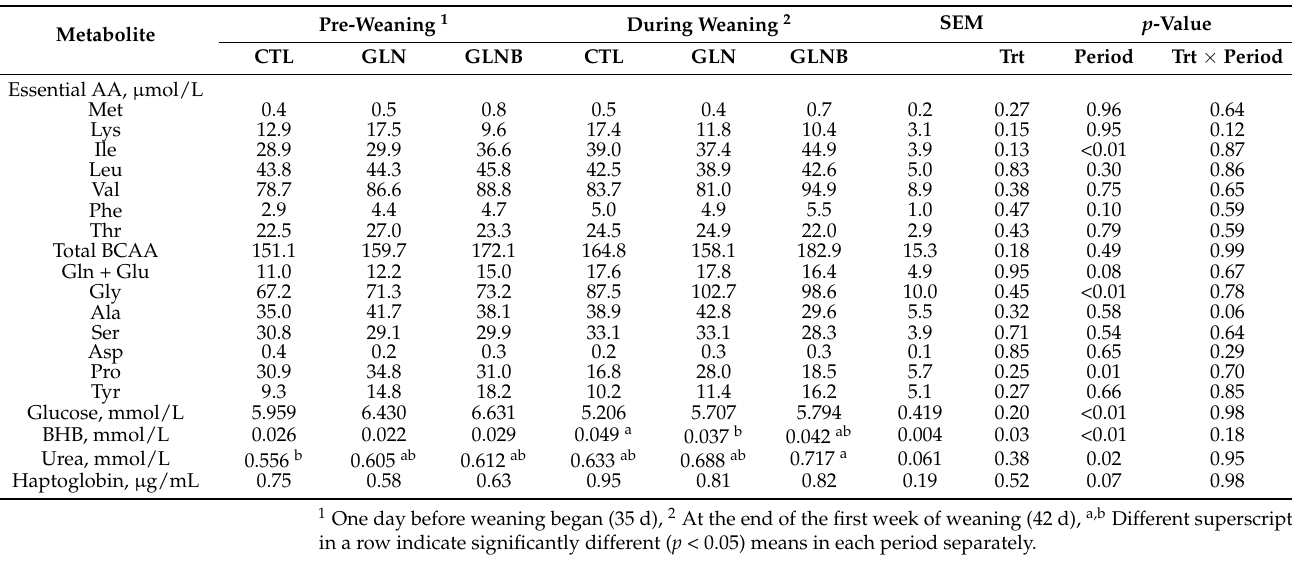
Table 2. Serum metabolite concentrations of dairy heifer calves undergoing a stepdown weaning scheme without AA supplementations (CTL) or with Gln (GLN) or Gln and branched-chain amino acid (GLNB) supplementations ( n = 11).